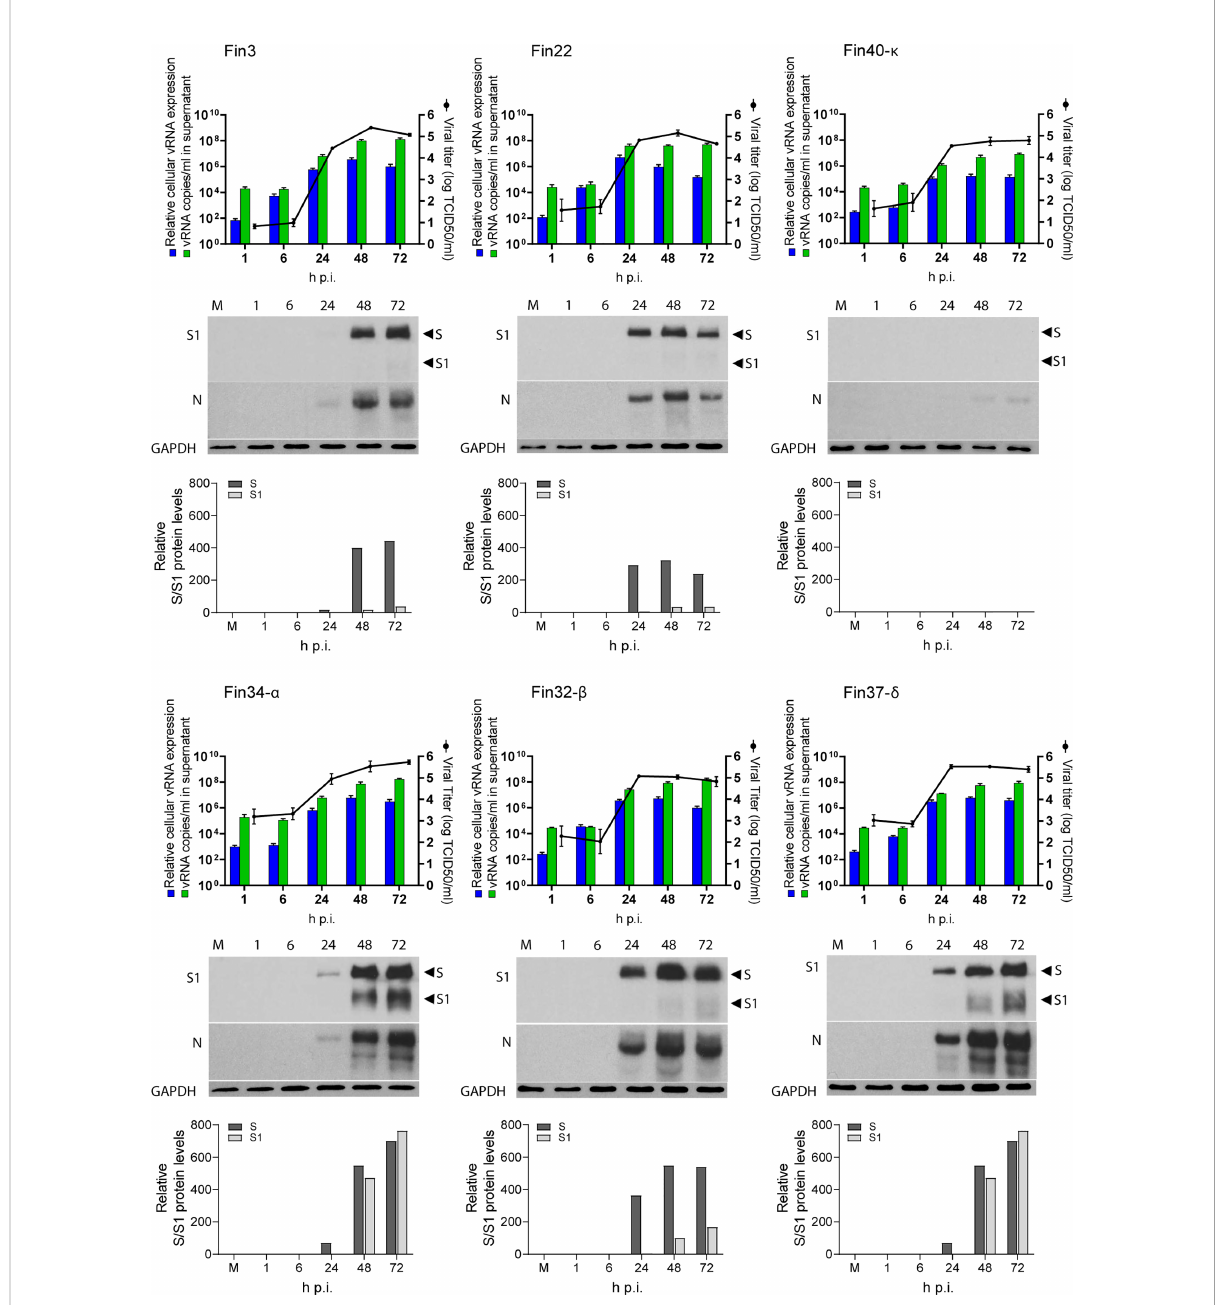
FIGURE 2 Replication of six SARS-CoV-2 variants in Calu-3 cells. Cells were infected with each variant at a MOI of 1 TCID 50 /cell. Cell culture supernatant and total cellular RNA and protein samples were collected at 1, 6, 24, 48 and 72 hours post-infection (h p.i.). The fi gure shows the replication pro fi les for each variant. The relative cellular vRNA expression levels and the quanti fi ed vRNA copies/ml in cell culture supernatant (as determined by RT-qPCR) is shown in the graphs on the left Y-axis. The production of infectious virions (as determined by an end point dilution assay and shown as log TCID 50 /ml) is shown on the right Y-axis. The results are the mean values ± SEM of three independent experiments. Cellular protein samples were analyzed by immunoblotting with anti-SARS-CoV-2 S1 (S1) speci fi c and cross-reactive anti-SARS-CoV N protein (N) speci fi c antibodies to show the replication kinetics of the viruses at a protein level. Immunoblotting was carried out once for S protein and three times for N protein. Representative immunoblots are shown. The anti-SARS-CoV-2 S1 antibody recognizes both the full-length S protein (S) and the cleaved S1 fragment. GAPDH was used as a loading control. The blots were exposed with an equal exposure time. S protein amounts quanti fi ed using ImageJ are shown below the